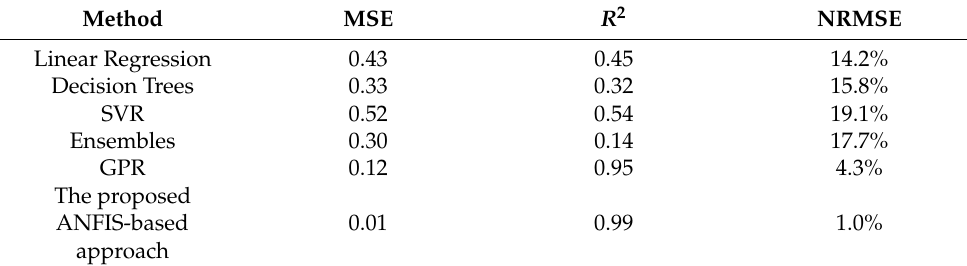
Table 6. Performance evaluation of the proposed approach with